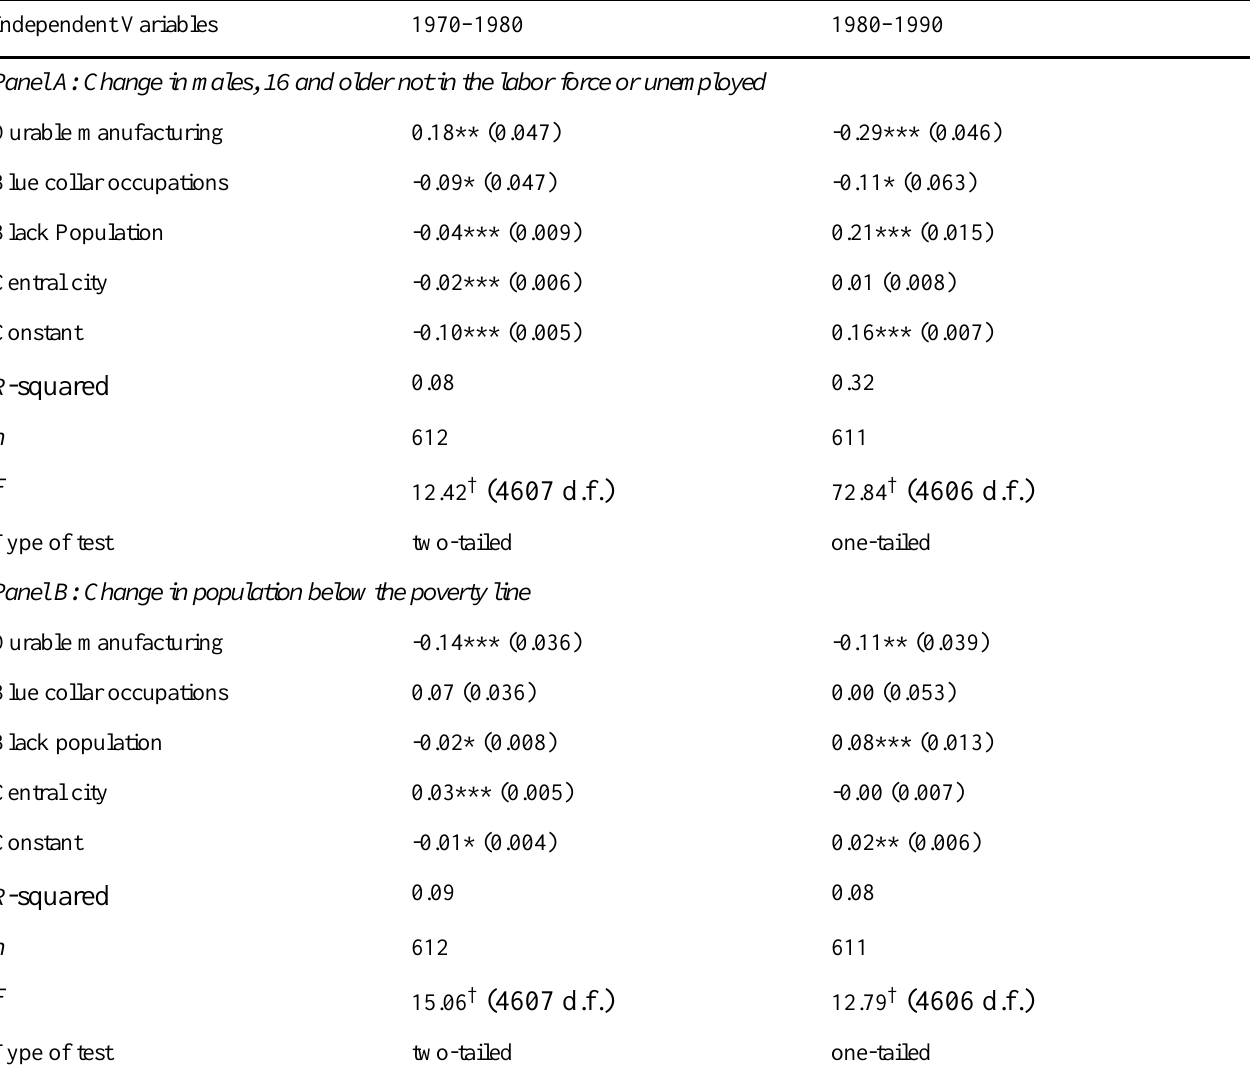
Table 6. Unstandardized coefficients for regional restructuring estimates on change in proportion of jobless males and population in poverty, Pittsburgh Standard Metropolitan Statistical Area Independent Variables Panel A: Change in males, 16 and older not in the labor force or